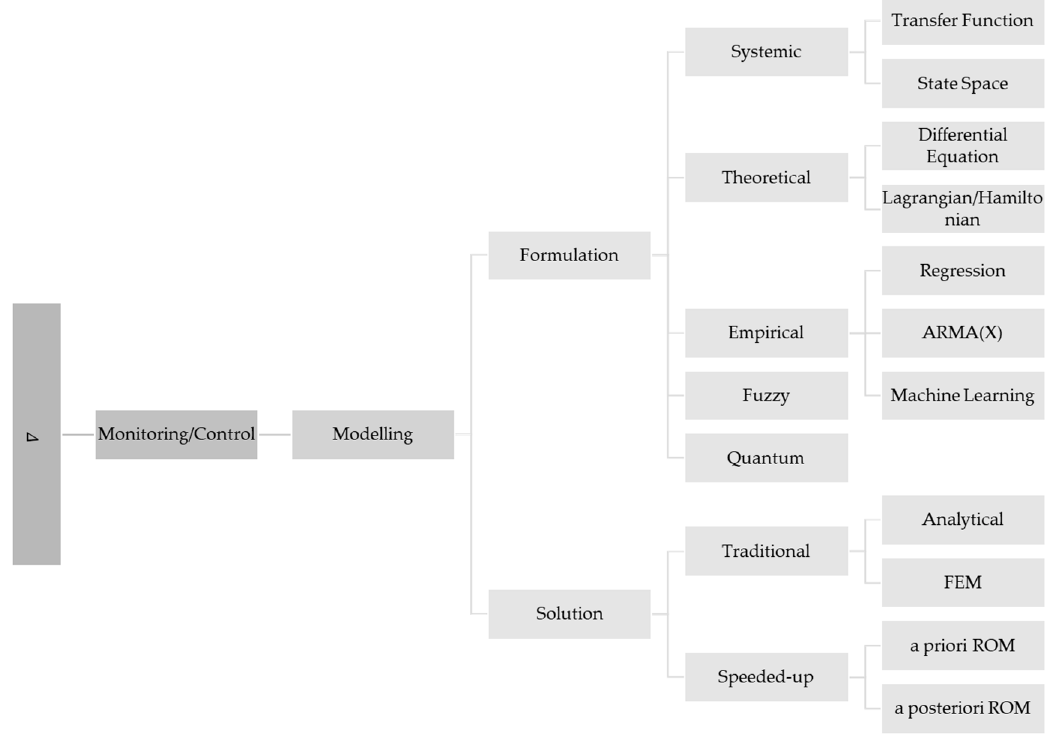
Figure A6. Technologies’ classification detail on modelling.